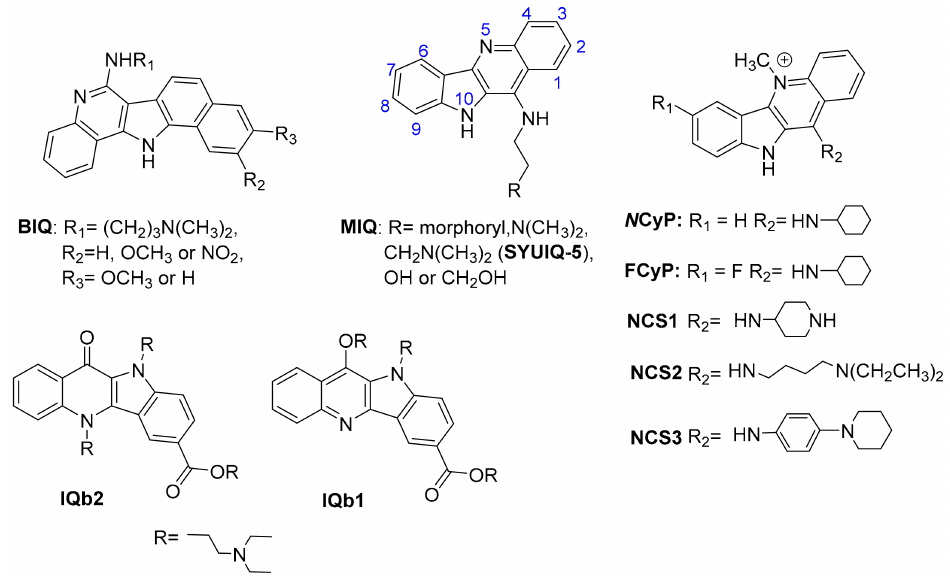
Figure 14. Structures of benzoindoloquinolines and indolo[3,2- b ]quinoline derivatives. Other studies exploited the indolo[3,2- b ]quinoline (or quindoline) tetracyclic aromatic core (Figure 14). Derivatives with one or two aminoalkyl substituents at C2, C7, C11 and N10 were shown to be potent and selective stabilizers of hTelo and oncogene promoter DNA G4s, as well as telomerase activity inhibitors and c-MYC expression downregula- tors [288–293]. In the case of monosubstituted indolo[3,2- b ]quinoline derivatives MIQ